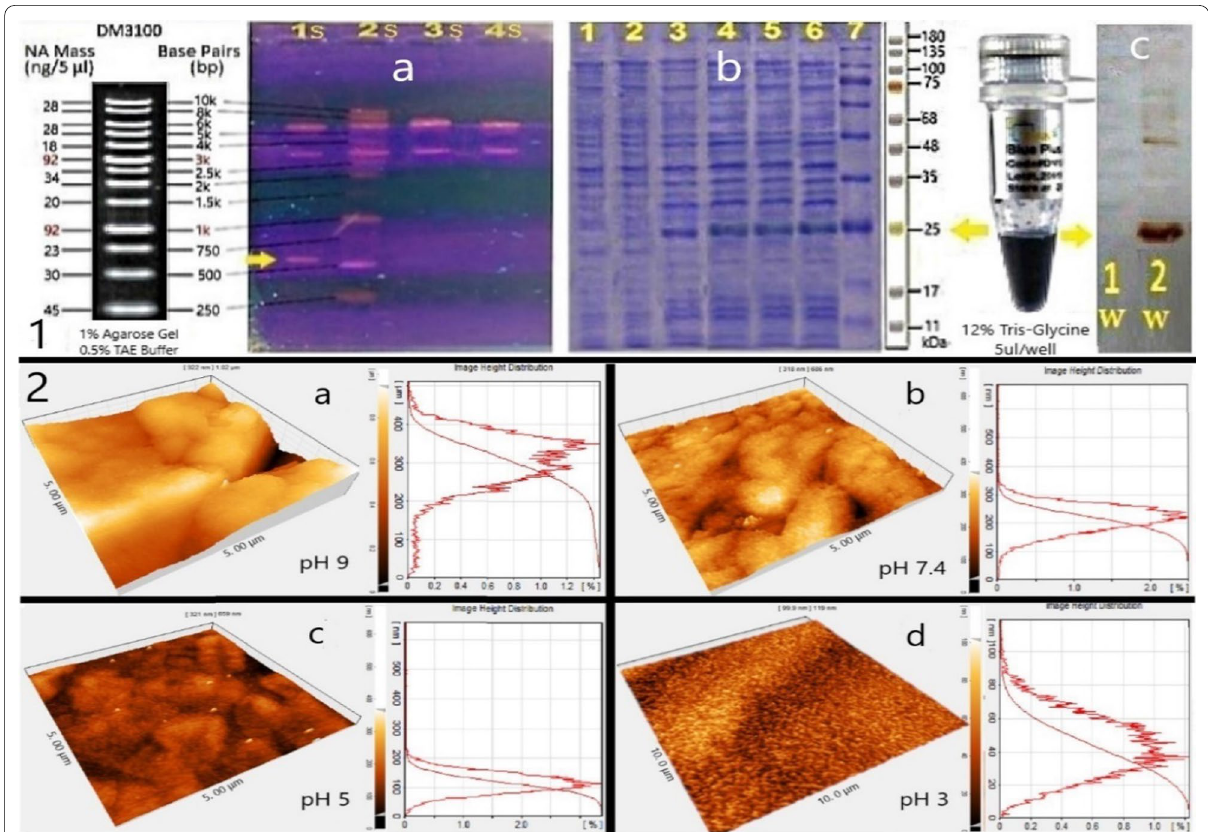
Fig. 8. 1 Cloning and expression results. a Isolated DNA fragments by electrophoresis gel; 1S, colony PCR, 600 bp amplified DNA fragments belongs to the CsgA-MFP3 hybrid gene; 2S, DNA ladder; 3S, Pst I restricted sample, plasmid cleavage within the MFP3 gene made it standing very slightly above the backbone plasmid; 4S, backbone plasmid. b SDS-PAGE gel; 1, zero-hour* (negative control); 2, first hour; 3, second hour; 4, fourth hour; 5, sixth hour; 6, eighth hour; 7, marker; c Western blot gel; 1 W, zero-hour (negative control); 2 W, fourth hour; *, expression hour. 2 Surface topographies of the chimeric CsgA-MFP3 protein together with height distribution diagrams for individual pH values. A section of 25 μm 2 at a pH 9, b pH 7.4, c pH 5, and d pH 3